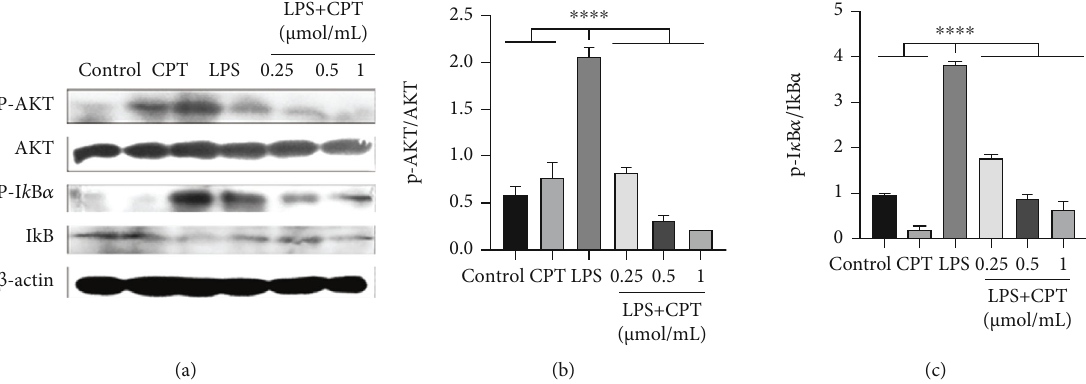
Figure 7: E ff ects of camptothecin (CPT) on LPS-induced activation of the AKT/NF- κ B signaling pathway in RAW264.7 cells. Total protein in RAW264.7 cells was collected following 4 h of LPS stimulation. CPT was added 1h before LPS stimulation. Protein levels of p-AKT and p- I κ B α were detected by western blot and quantitatively assessed via densitometry using (a, b) AKT and (a, c) I κ B α as internal controls. Protein levels were measured using ImageJ (http://imagej.nih.gov/ij/) and normalized to the protein level of AKT and I κ B α . Values are presented as mean ± SD ( ∗∗ P < 0 : 01 vs. LPS, ∗∗∗∗ P < 0 : 0001 vs.